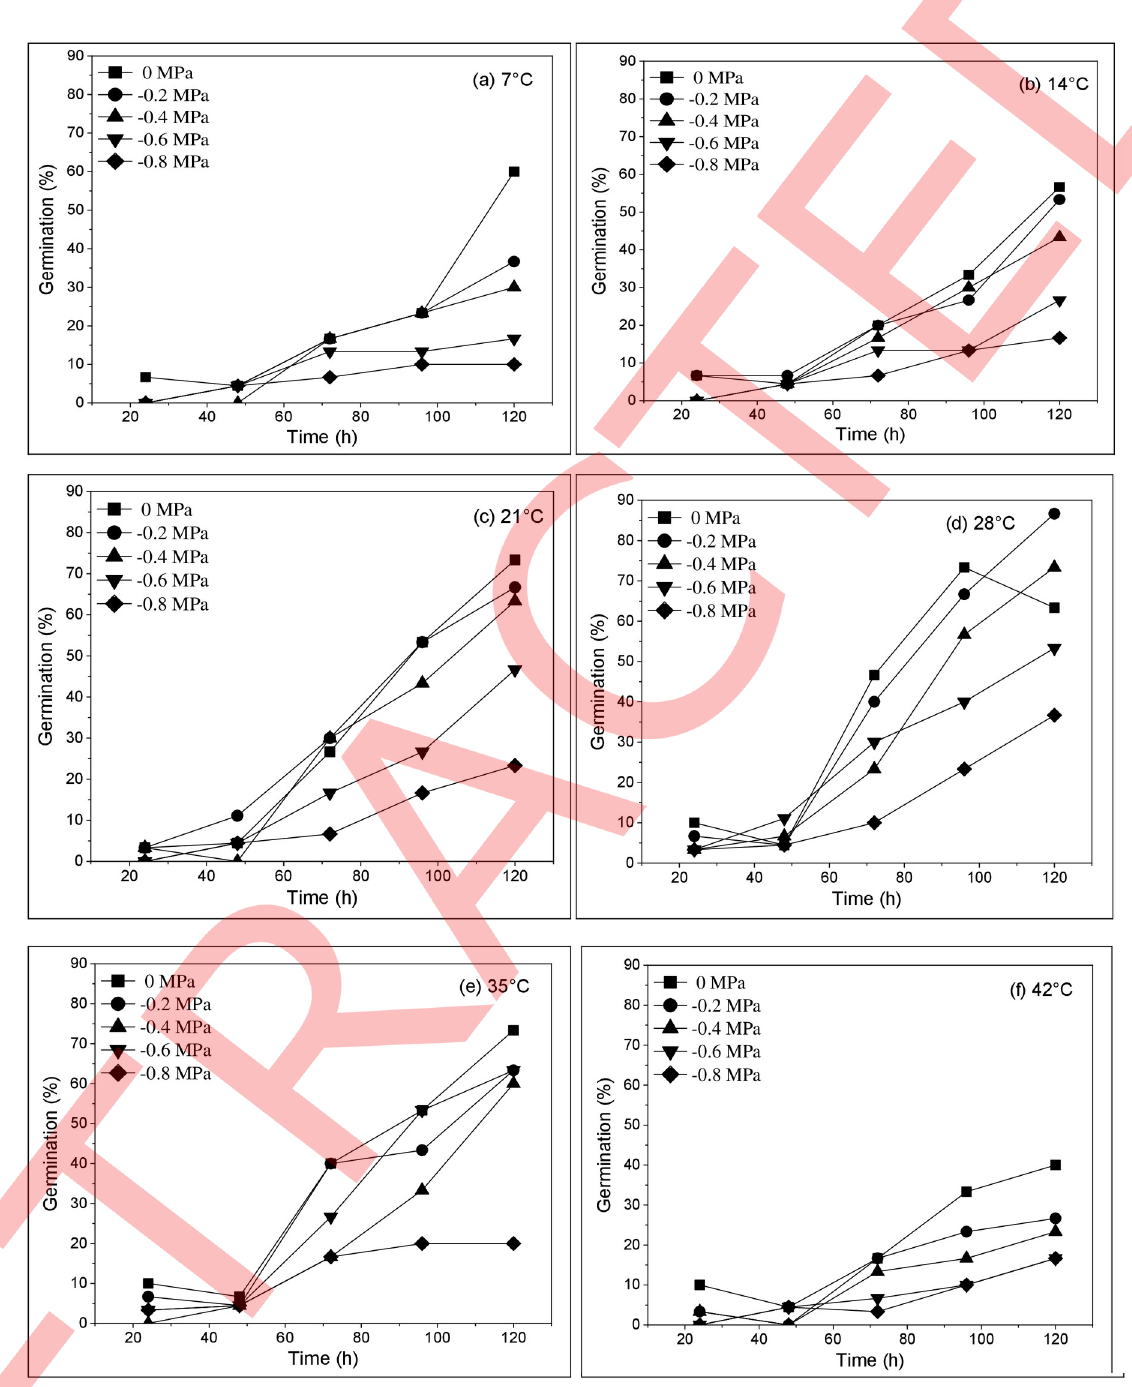
Fig 1. Cumulative germination fraction for Cicer arietinum at ( a ) 7˚C, ( b ) 14˚C, ( c ) 21˚C, ( d )28˚C, ( e )35˚C and ( f ) 42˚C having different water potentials (0, -0.2, -0.4, -0.6, -0.8 MPa). Symbols indicate water potential and lines indicate cumulative germination fraction predicted by hydrothermal time